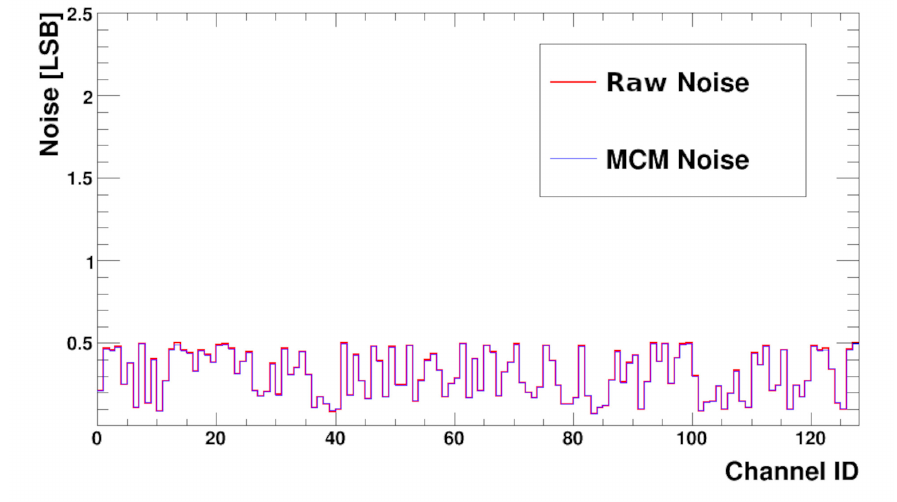
Figure 13. Baseline noise Root Mean Square (RMS) versus channel number before (Raw Noise) and after (MCM Noise) MCM correction; sensor not